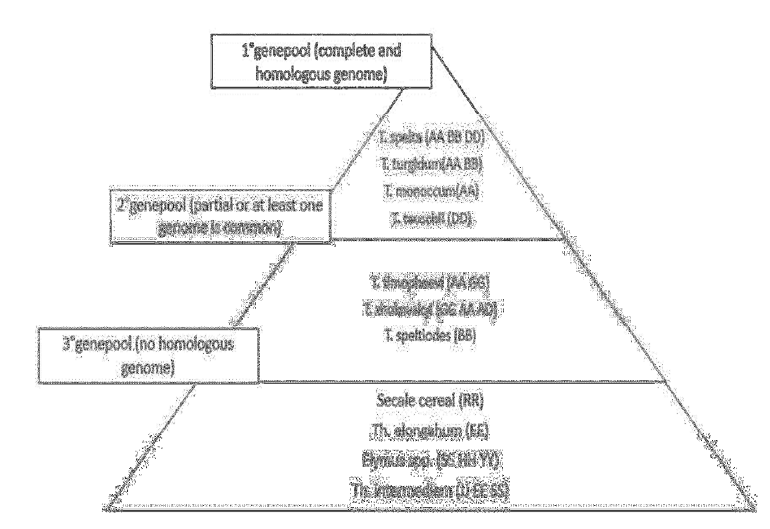
Fig. 7. Wheat gene pool representing various species (Pratap et al. ,